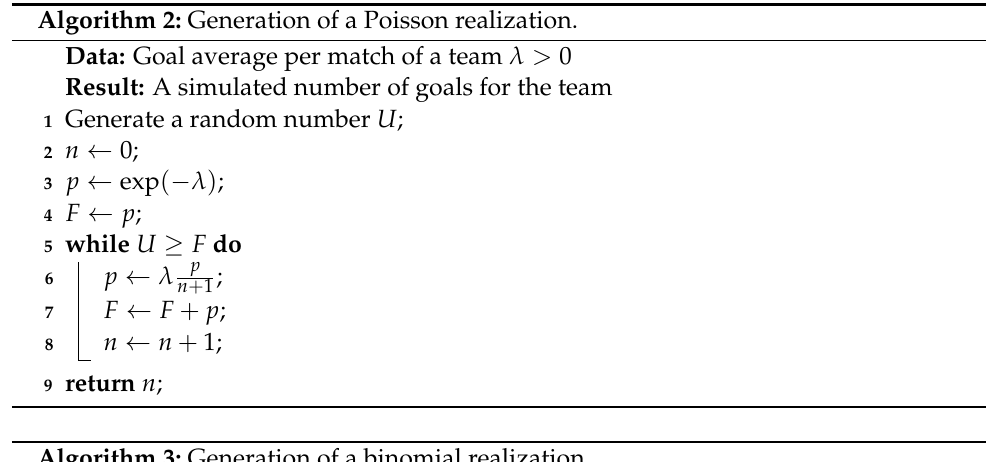
Algorithm 3: Generation of a binomial realization. Data: Goal average per match of a team ¯ x >